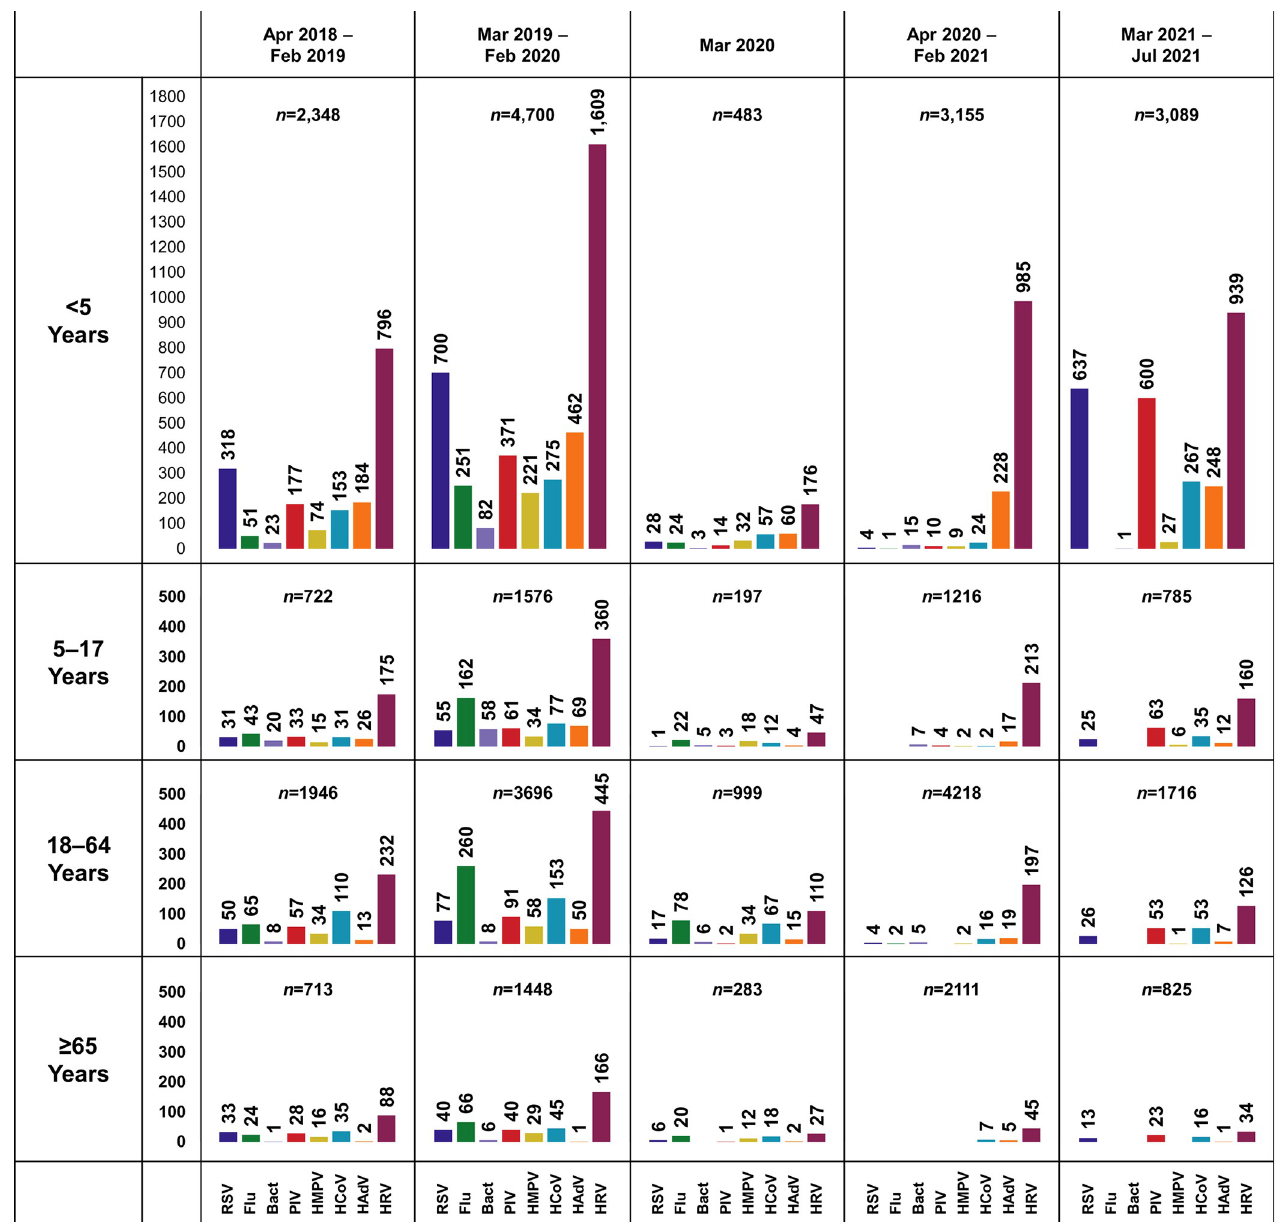
Fig 2. Frequency of respiratory pathogens from April 1, 2018, through July 31, 2021, stratified by age groups and by following the periods: Pre-pandemic (April 2019-Feb 2019; March 2019-Feb 2020), March 2020 as the transitional month, and pandemic period (April 2020-Feb 2021, March 2021-July 2021). Abbreviations: RSV, respiratory syncytial virus; Flu, influenza; PIV, parainfluenza virus; HMPV, human metapneumovirus; HCoV, human coronaviruses; HAdV, human adenovirus; HRV/EV, human rhinovirus/enterovirus.